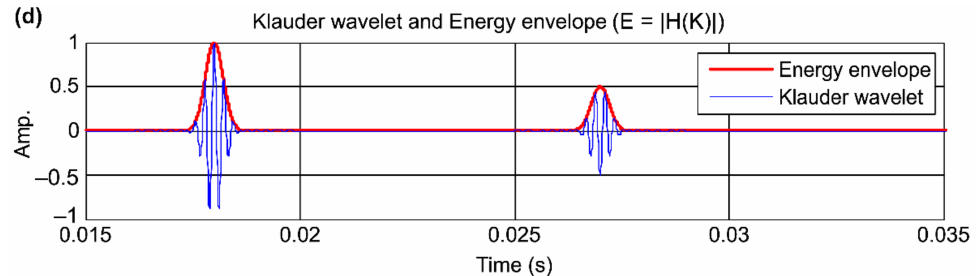
Figure 3. Synthetic Chirp sub-bottom profiler (SBP) waveform generation. ( a ) Reflectivity coefficient (R). ( b ) Convolving source wavelet and reflectivity function; S = W*R. ( c ) Generation of Klauder wavelet (blue line) by correlating the source wavelet and S; K = W*S. ( d ) Envelope generation (red line); E = |H(K)|.